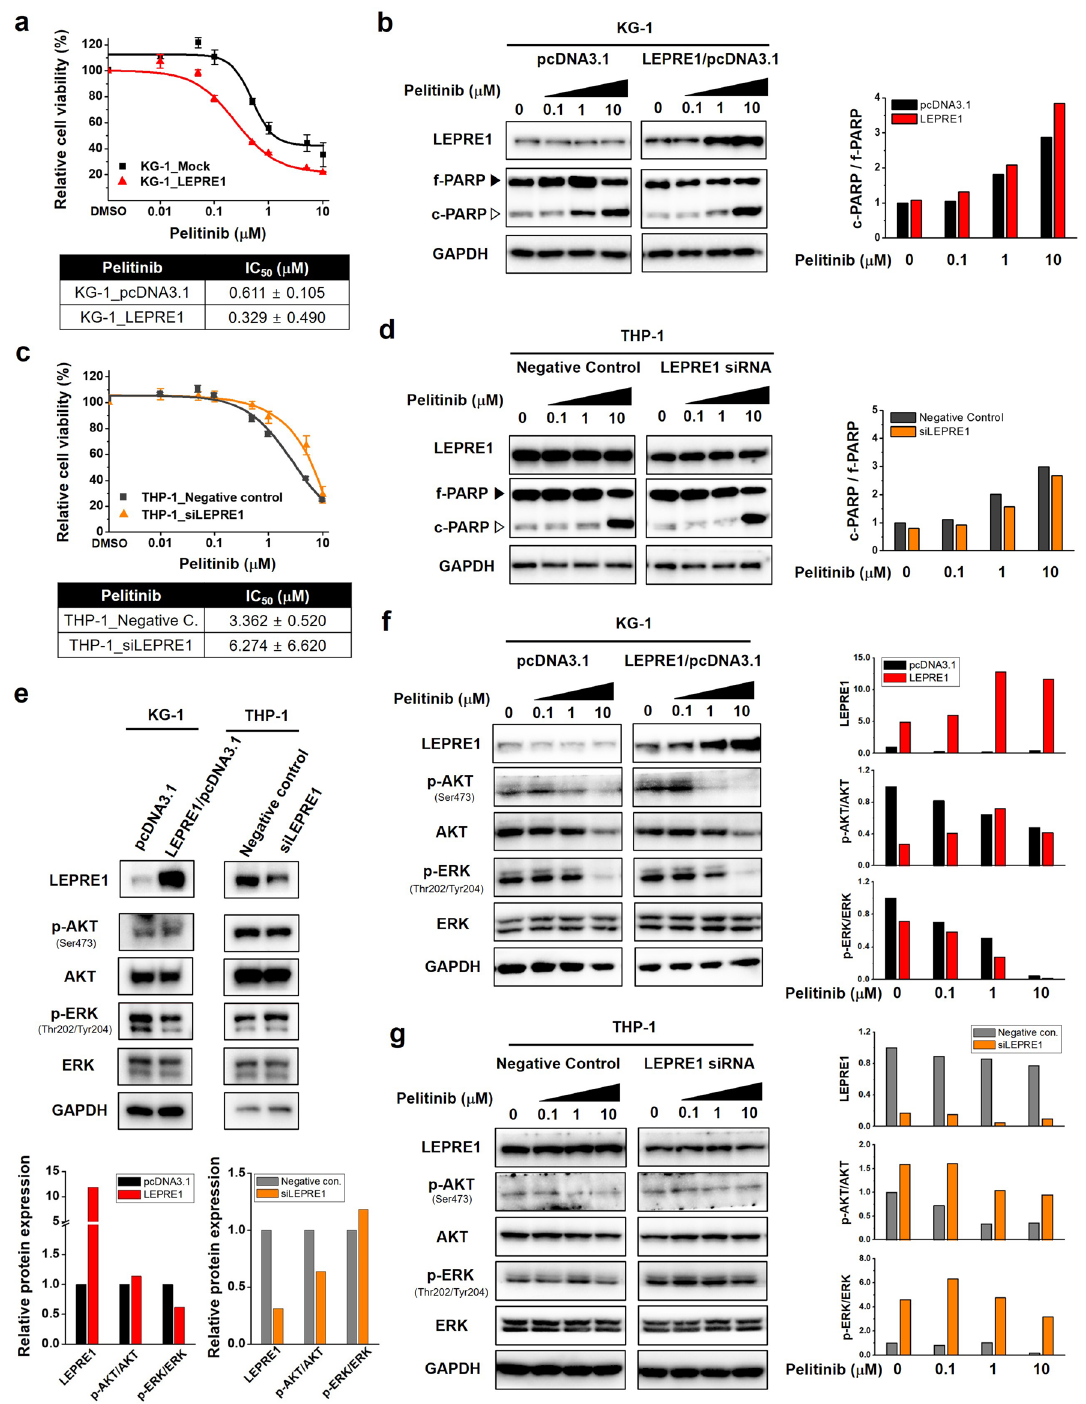
Figure 2. LEPRE1 expression levels in AML-derived cell lines regulate cell survival against pelitinib. (a,c ) Transfected KG-1 cells ( a ) and THP-1 cells ( c ) treated with pelitinib for 3 days. Cell viability was determined using a WST-1 proliferation assay. ( b , d ) Overexpression of LEPRE1 in KG-1 cells ( b ) and knockdown of LEPRE1 in THP-1 cells ( d ) treated with 0, 0.1, 1, 10 μM of pelitinib for 24 h. Whole-lysates extracted from these cells were subjected to western blot analysis with PARP antibody. Band intensities were quantified by densitometric analysis and normalized by GAPDH. f-PARP, full-length PARP; c-PARP, cleaved PARP. ( e ) KG-1 and THP-1 cells transfected with pcDNA3.1 and LEPRE1/pcDNA3.1 or with Negative control siRNA and LEPRE1 siRNA, as indicated. After 48 h, p-AKT, AKT, p-ERK, and ERK expression levels were determined by western blot analysis. ( f , g ) KG-1 and THP-1 cells were transfected with pcDNA3.1 and LEPRE1/ pcDNA3.1 ( f ) or Negative control siRNA and LEPRE1 siRNA ( g ) and then treated with the indicated concentration of pelitinib (0, 0.1, 1, 10 μM) for 24 h. Cell extracts were prepared and immunoblotted using the indicated antibodies. GAPDH was used as an internal control. All western blots are pre-cut. Membranes were often stripped and reprobed for multiple